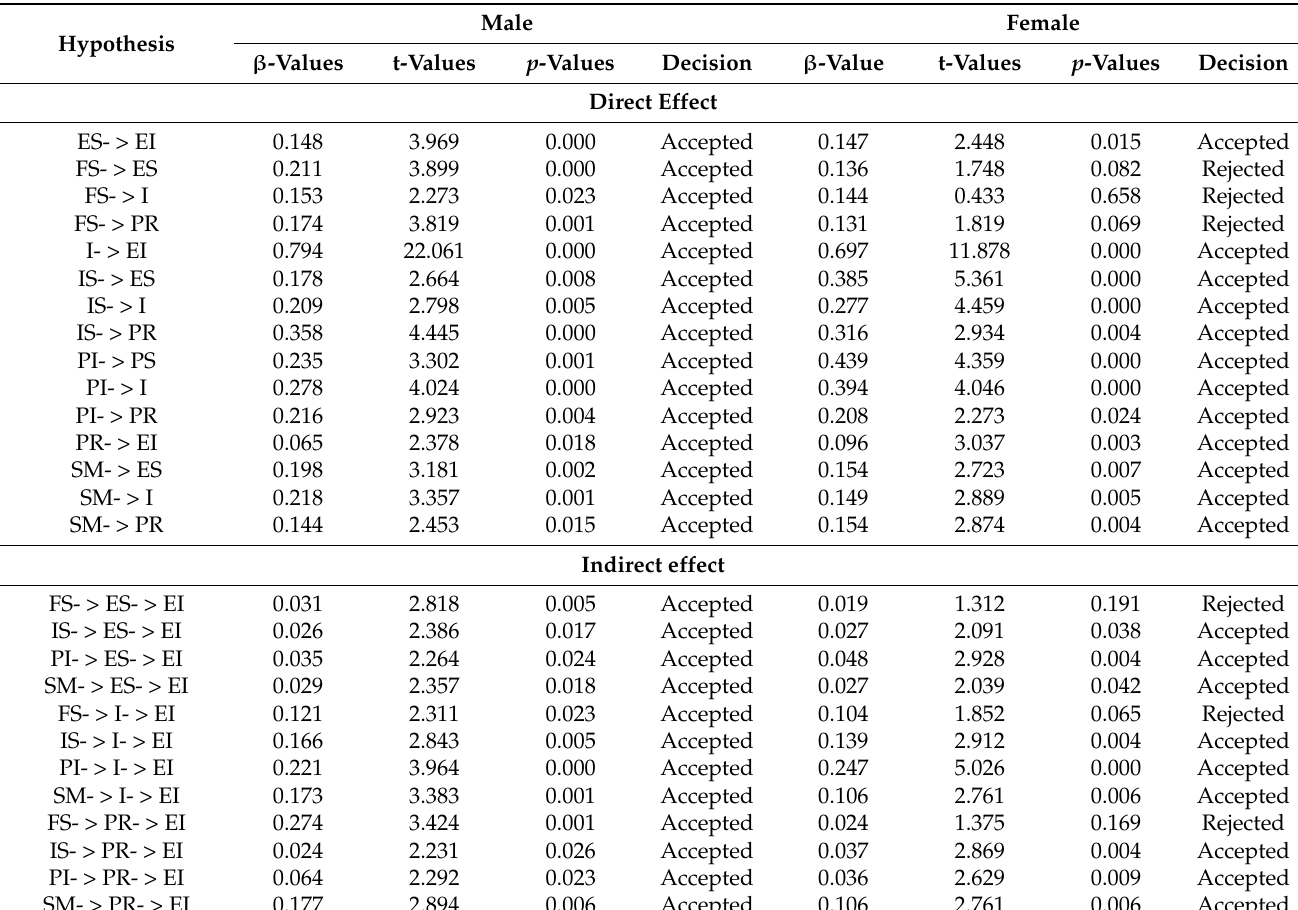
Table 7. Comparative analysis for gender.